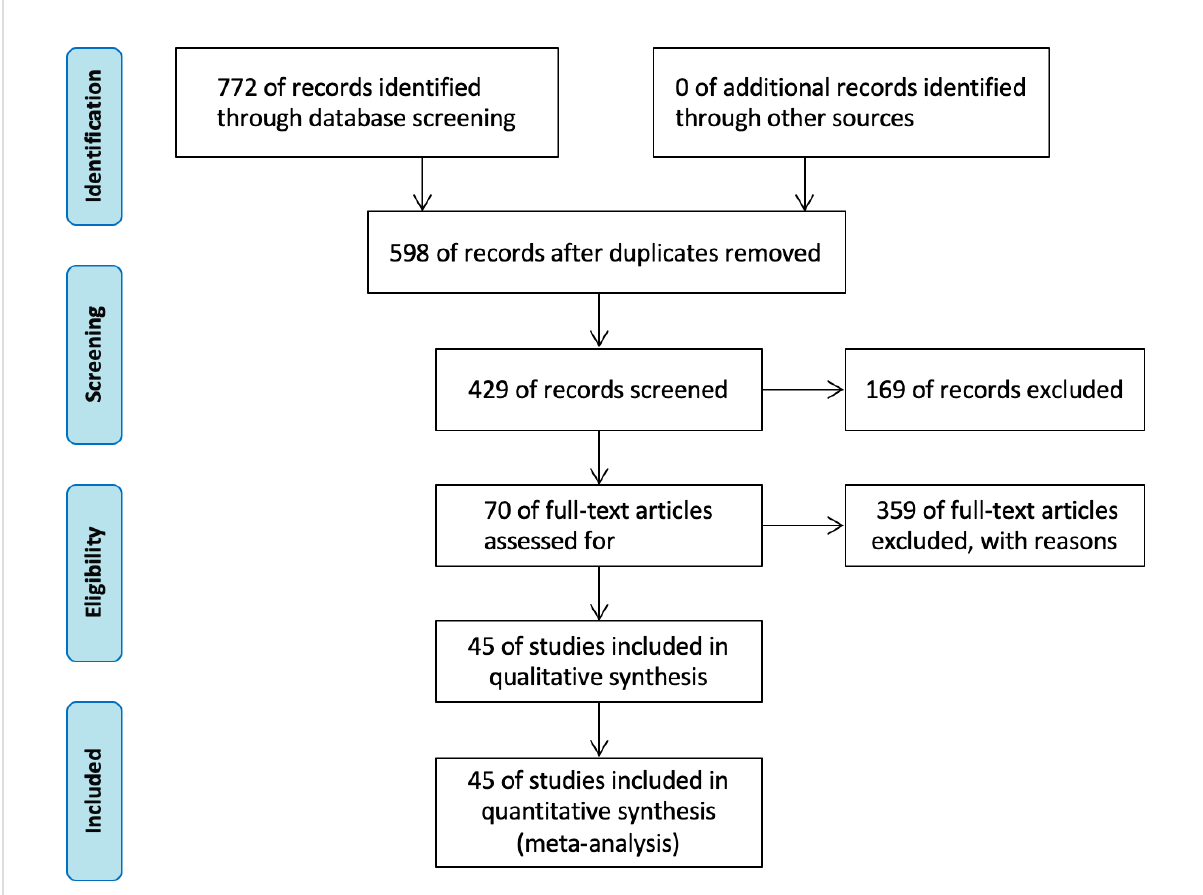
FIGURE 1 Flow diagram of the study search and selection in this